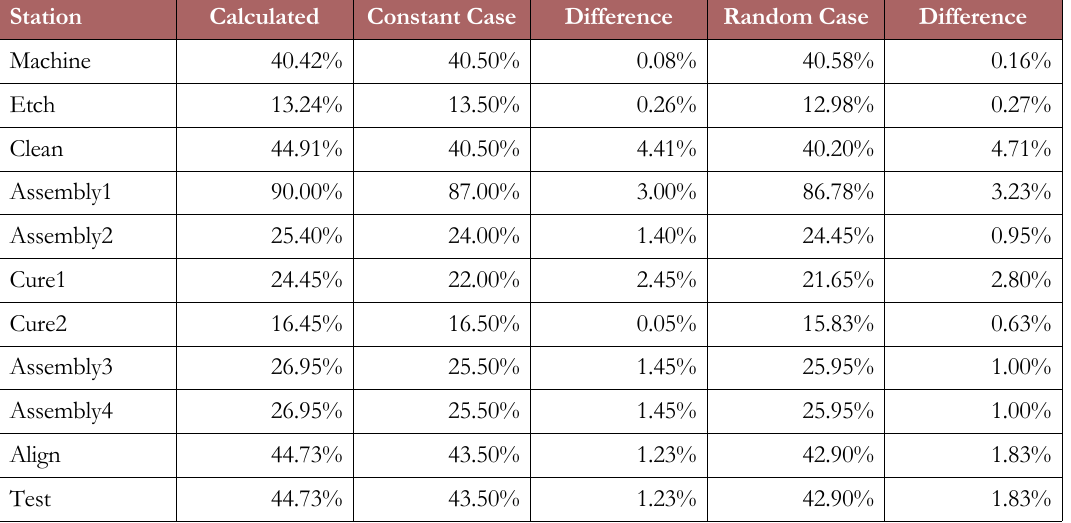
Table 7. Individual Resource Utilization Comparison and Validation For POLCA